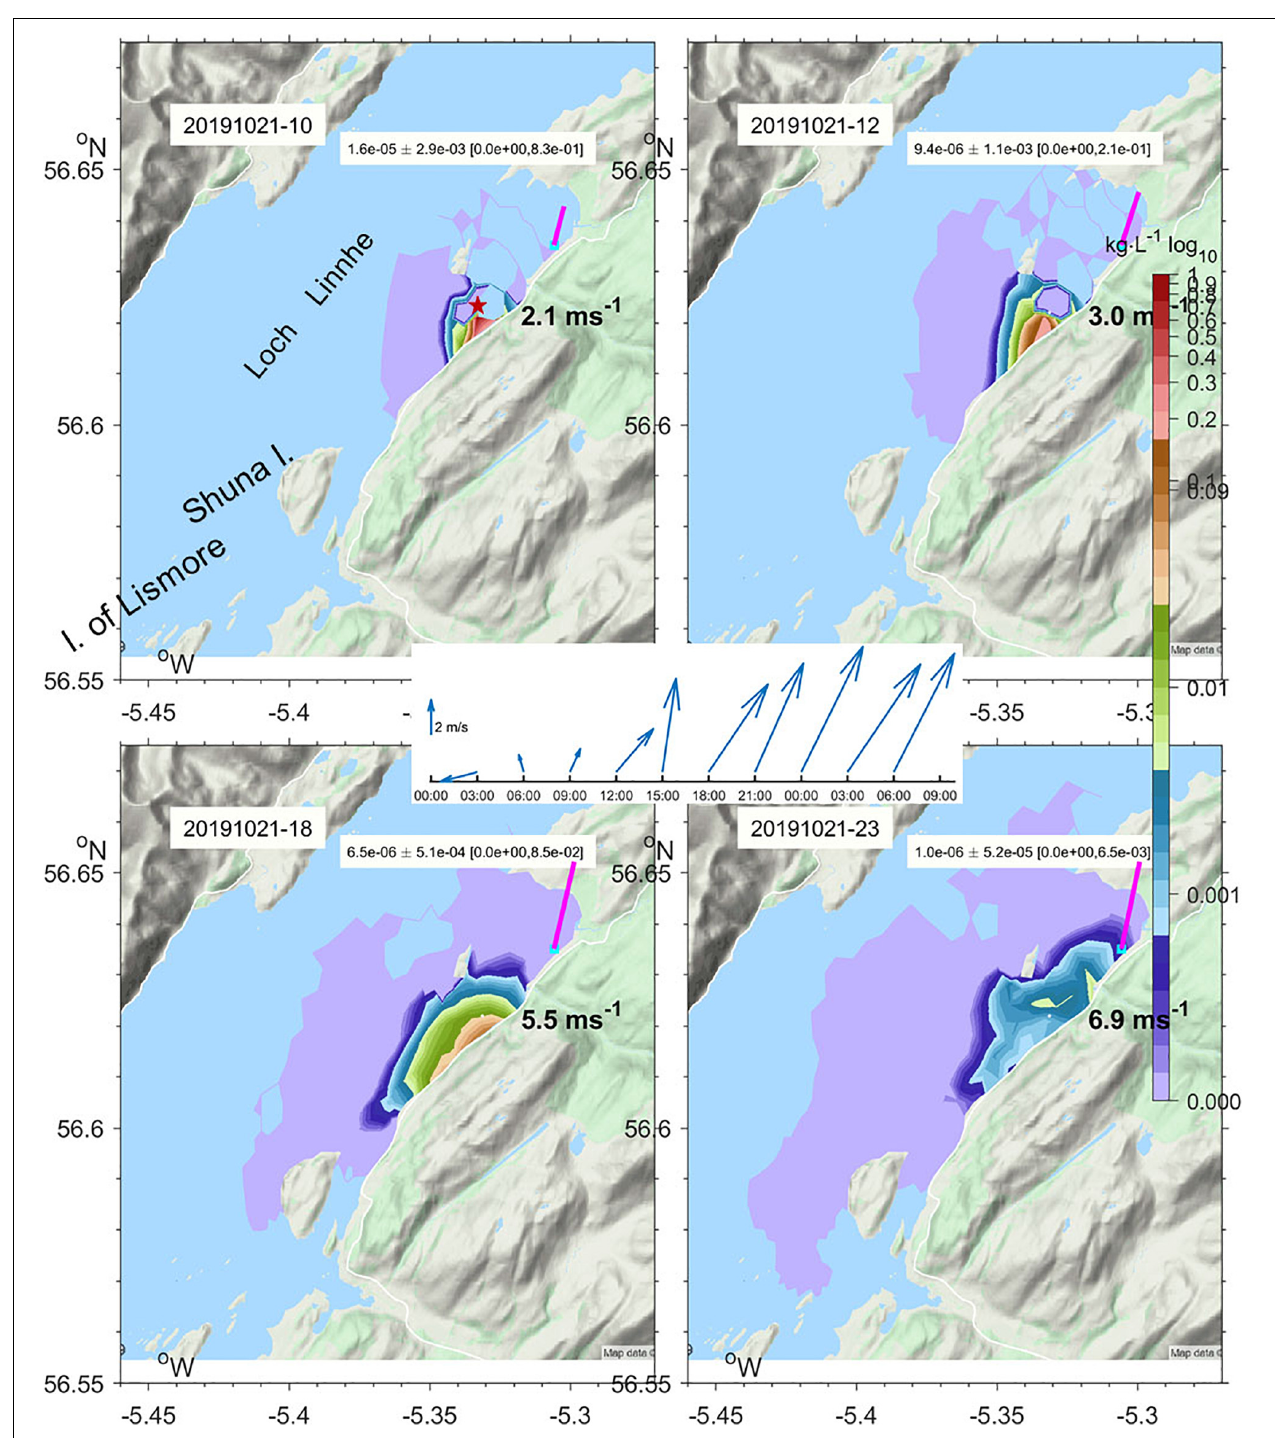
FIGURE 7 | Subsurface maximum concentration of Rhodamine-WT Dye under the tide and prevailing wind (vectors) predicted by WeStCOMS v2 model on 21st October 2019 at 10, 12, 18, and 23 GMT. The site where dye was released at 09:21 is marked with a